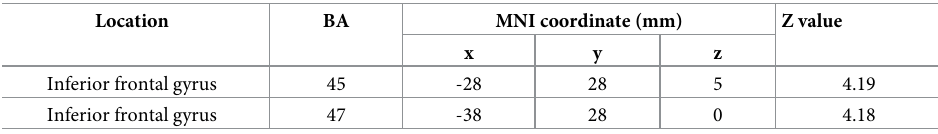
Table 1. Brain regions in which an interaction was observed between sessions and